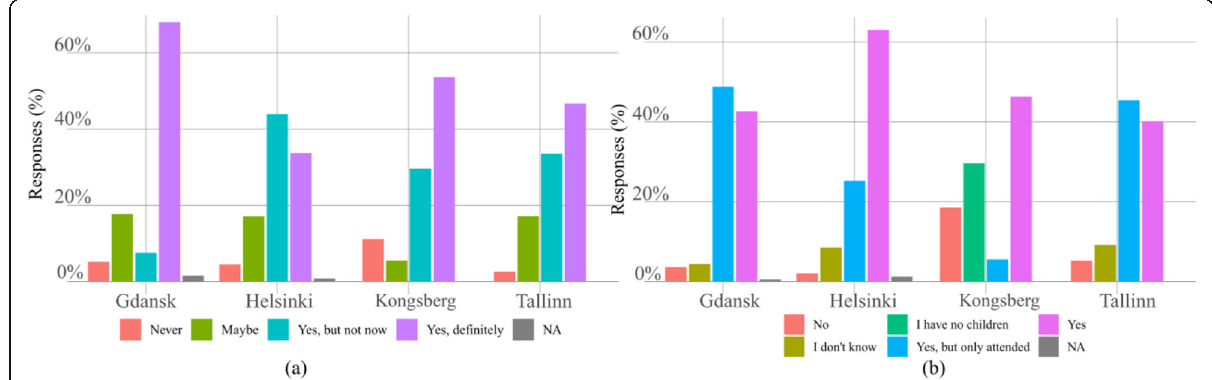
Fig. 4 Responses to the questions: ( a ) use the service without operator, and ( b ) service suitable for children. Questions n. 3 and 5